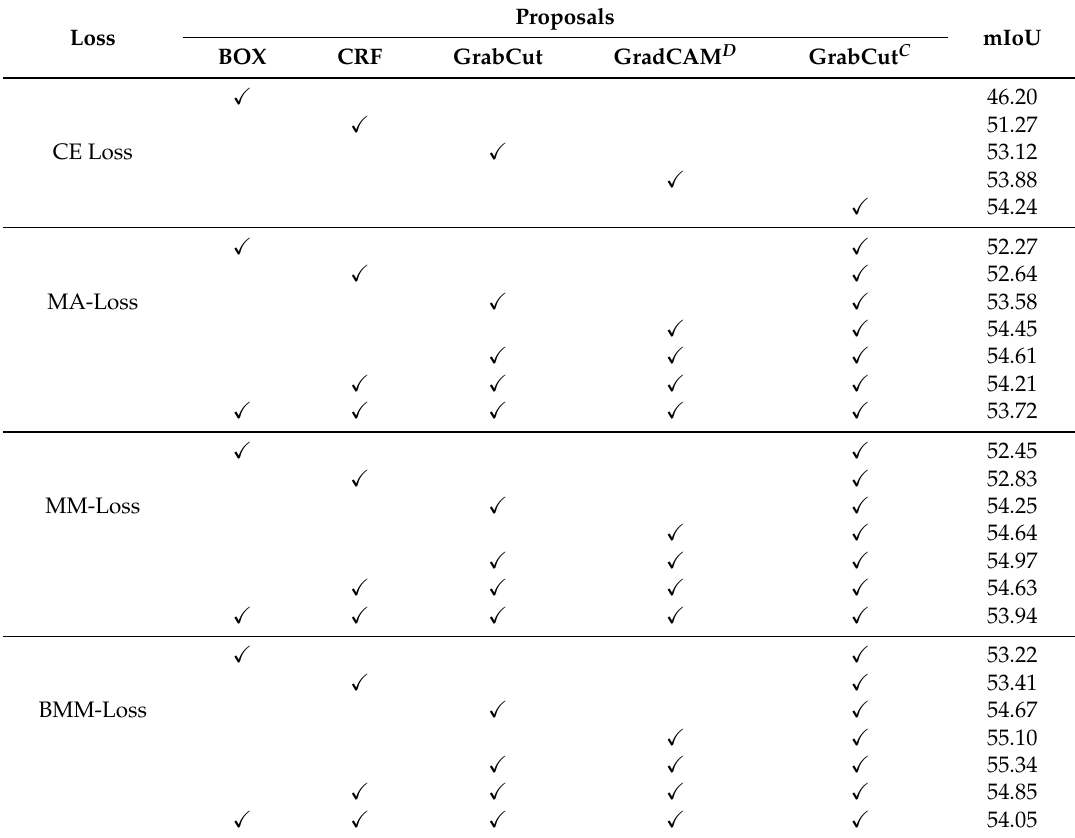
Table 1. Evaluating the effectiveness of JMLNet, including GradCAM D proposals, GrabCut C proposals and three novel loss functions on iSAID validation set. BOX: Rectangle proposals, CRF: CRF proposals, GrabCut: GrabCut